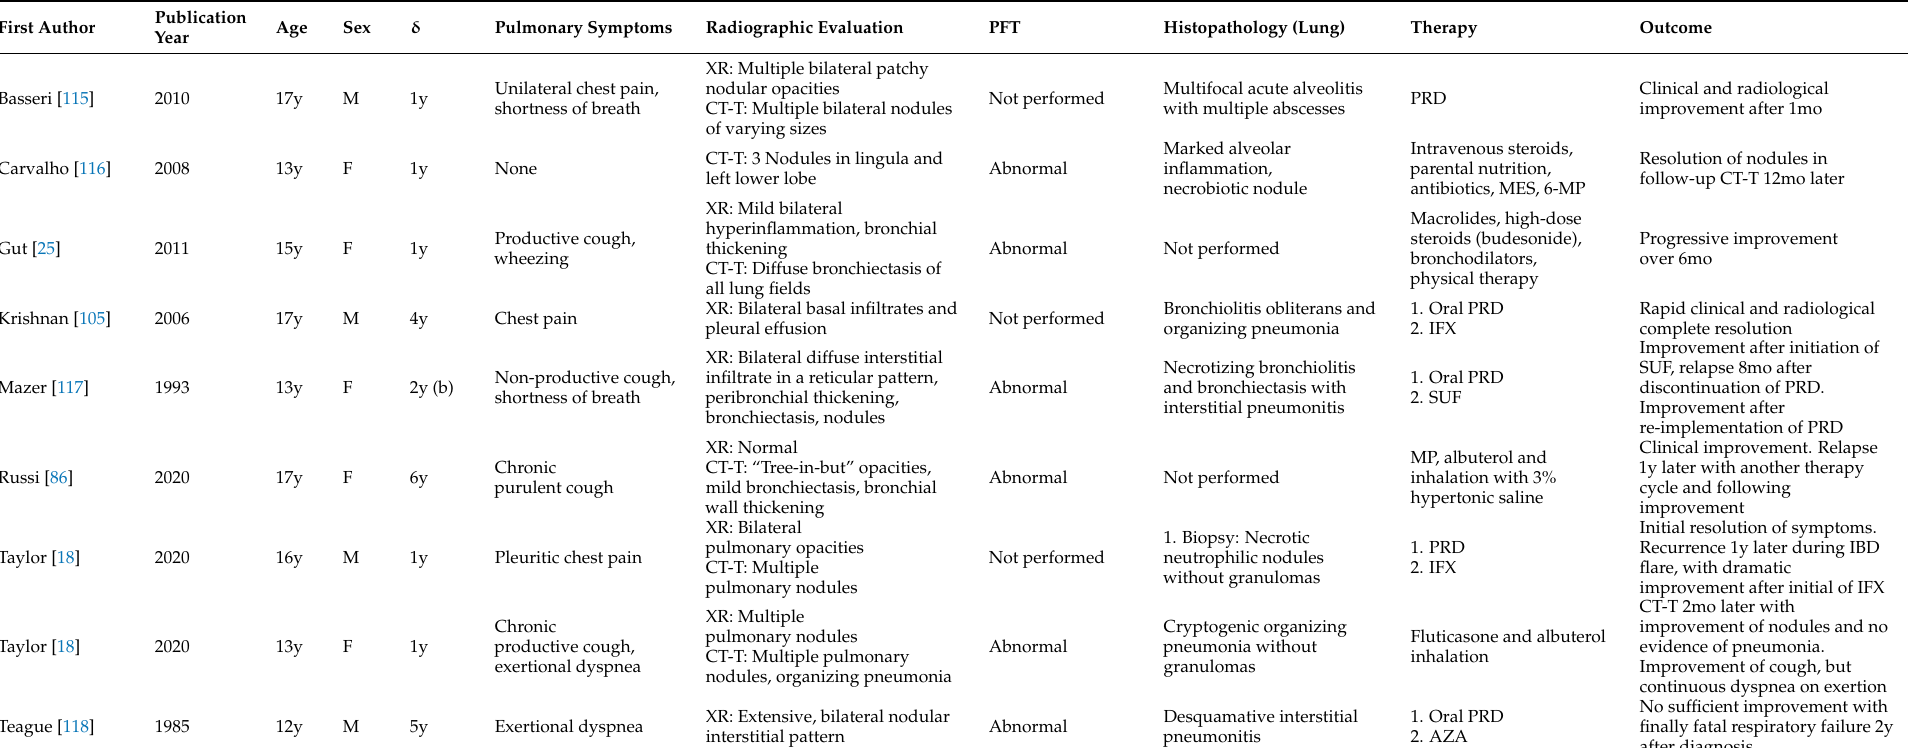
Table 2. Published cases of pulmonary manifestations in pediatric UC